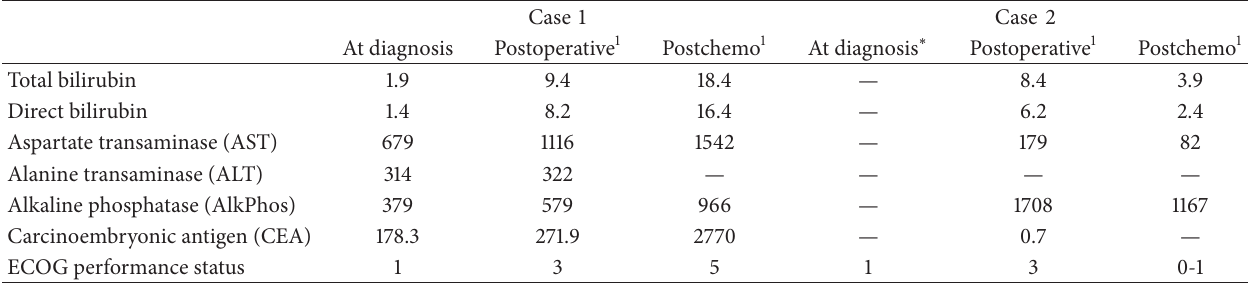
Table 1: Pertinent trends in laboratory investigations and clinical parameters for Cases 1 and 2.